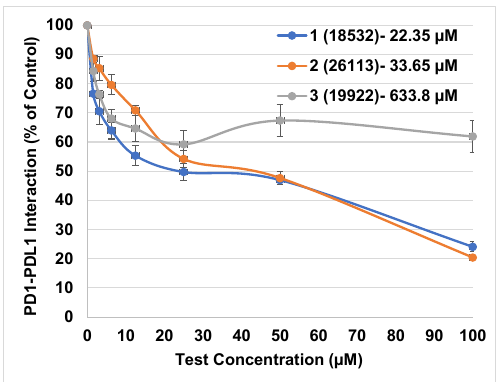
Figure 3. Dose–response HTRF data for small-molecule inhibitors of PD1-PDL1 interaction. To study possible molecular interactions and binding stability of our active compounds in comparison to the crystal ligand 8HW within the PDL1 dimer interface, their top-ranked Vina docking complexes were subjected to molecular dynamics simulations (Desmond Molecular Dynamics System from D. E. Shaw Research, New York, NY, USA). The root mean square deviation (RMSD) analysis of the best active compounds 1 and 2 over 5 ns molecular dynamics simulation revealed their stable binding within the PDL1 dimer pocket (Figure 4A). Our top hit compound 1 (IC 50 ~22.35 µM) showed similar binding stability as the crystal ligand 8HW. After initial configuration change, compound 1 did not deviate much, exhibiting consistent RMSD value around ~2.0 Å at the end of the 5 ns simulation period, thus indicating its stable binding at the PDL1 dimer interface. The ligand RMSD value for compound 2 was ~3.0–4.0 Å, which is consistent with its slightly higher IC 50 value of ~33.65 µ M. Here, it should be noted that the RMSD profile for ligand-bound PDL1 backbone for both compounds 1 and 2 fluctuated as high as ~5.0 Å, as compared to observed ligand–protein stability in case of crystal ligand 8HW. For compound 3 (19922), a high ligand RMSD value of ~8.0 Å was observed, coinciding with its very high IC 50 value of ~633.80 µ M.